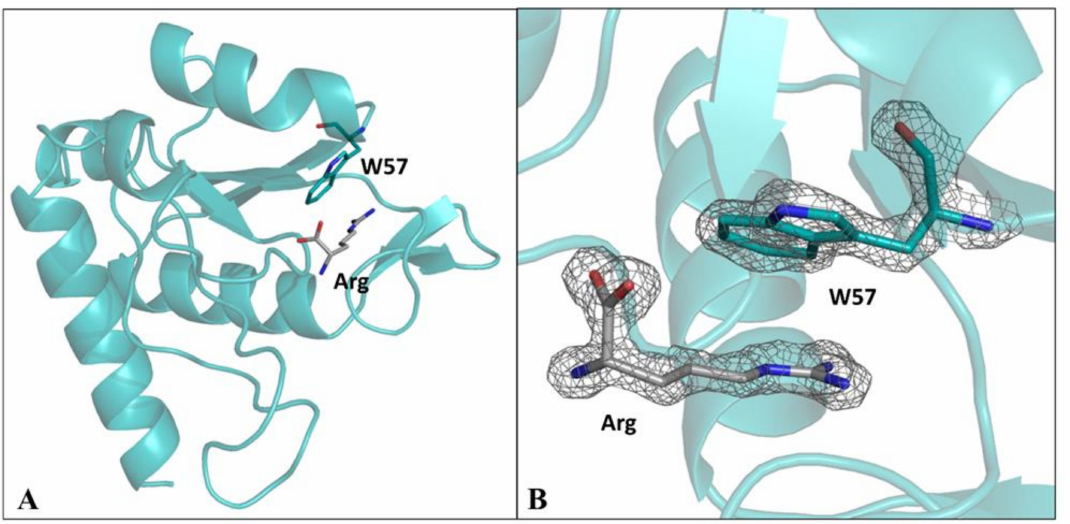
Figure 7. Crystal structure of the arginine-bound D1 F57W from TmArgBP. The arginine ligand and W57 residue are shown as sticks ( A ). | 2Fo − Fc | electron density map, contoured at 2.0 σ , of the arginine ligand and of the mutated residue W57 ( B